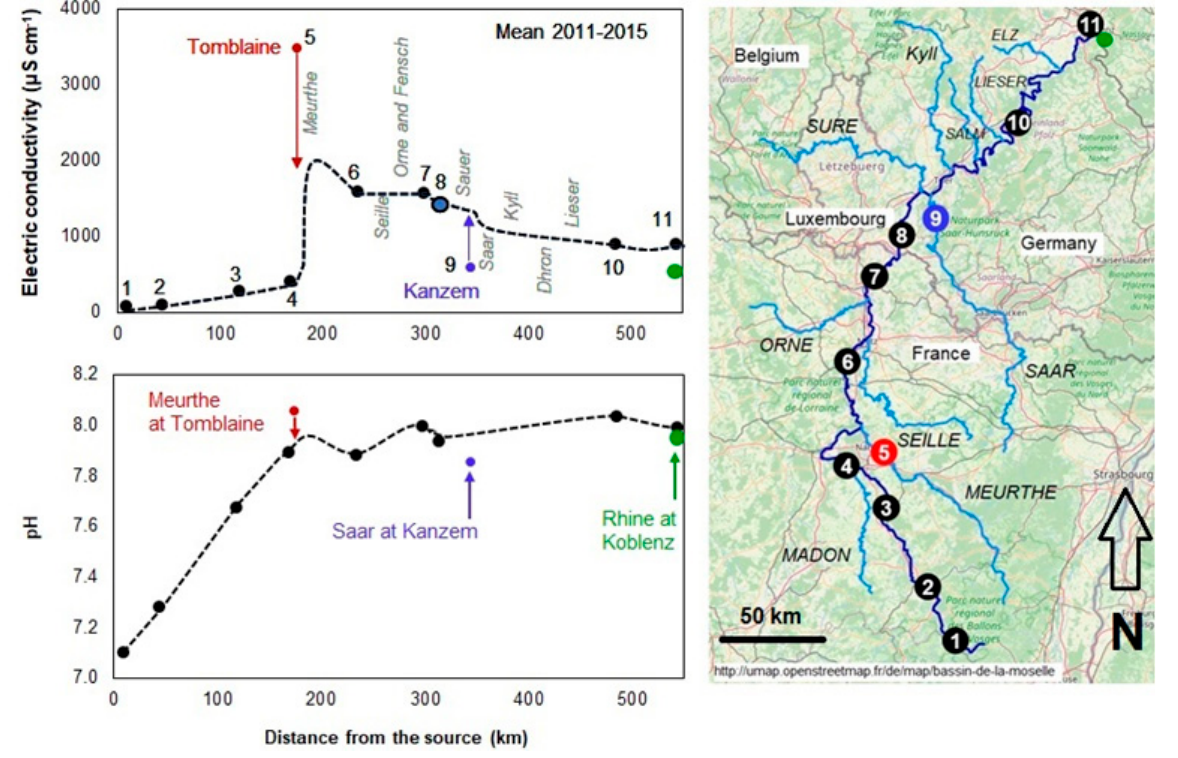
Figure 1. Five-year average (2011–2015) of electric conductivity (EC), representing the quantity of total dissolved solids (TDS), at different points downstream of the river Moselle ( upper left ) and the representative pH values ( lower left ). A map of the Moselle catchment area and its tributaries (light blue) is shown at the right . Red dots and arrows represent higher EC and pH of the water of the Meurthe river southeast of Nancy before it enters the Moselle. Blue points and arrows indicate the relatively lower EC and pH of waters from the river Saar, which leads to the dilution of the Moselle water. Green points and arrow indicate the mean values for EC and pH determined in the Rhine before water enters the Moselle. According to the BfAG FGG database, the average EC (450 μ S m − 3 ) is much lower in the Rhine, while pH is almost the same as in the Moselle. The names of major rivers entering the Moselle downstream from the left (northern) and right (southern) sides are indicated in gray. Numbers refer to different stations (see Table 1 and map above). Only the data from Palzem (station nr. 8) are presented in greater detail in the rest of the paper. http: